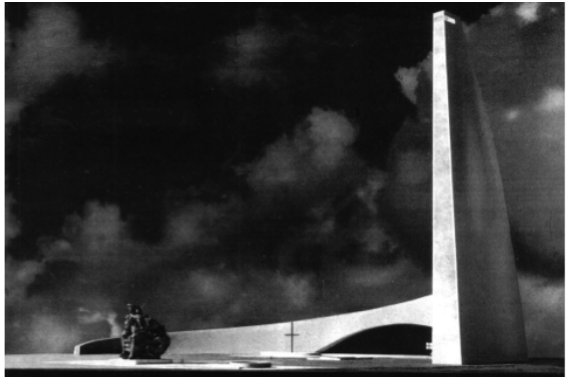
FIGURE 7 | J. Andresen, B.Feyo, J. Resende, Mar Novo 1956,